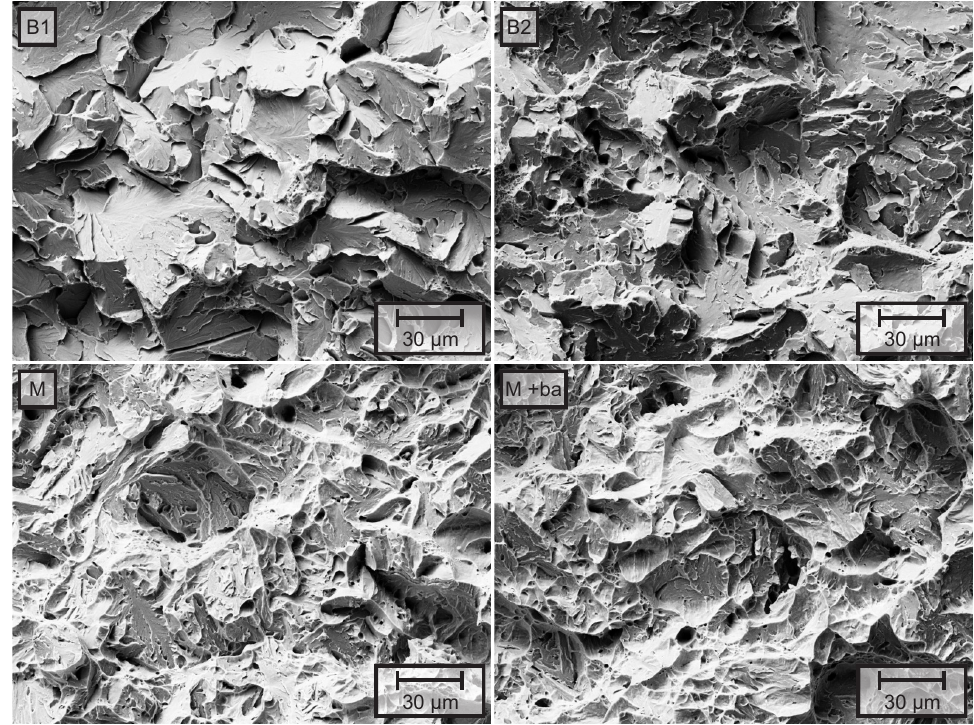
Figure 9. Fracture surface of Charpy V-notch impact test samples: Comparison of the areas where mostly brittle fracture can be